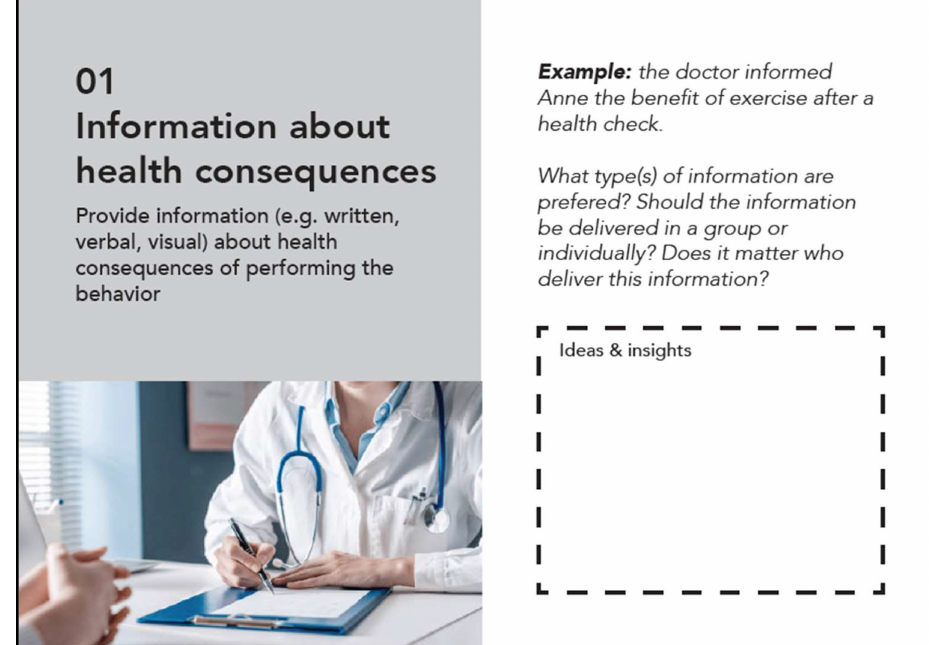
Figure 4. Example of a BCT card.